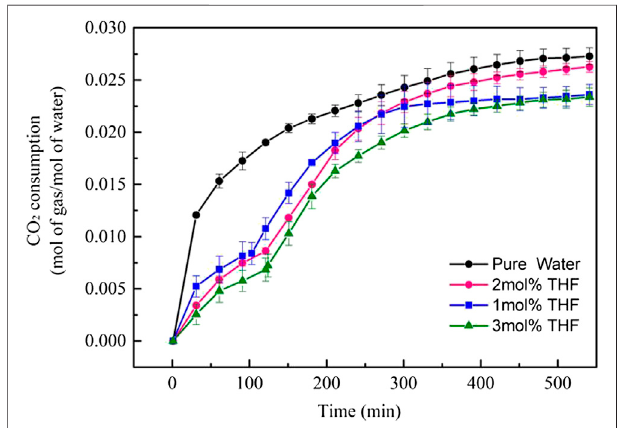
FIGURE 4 | CO 2 consumption curves (normalized by water amount) duringCO 2